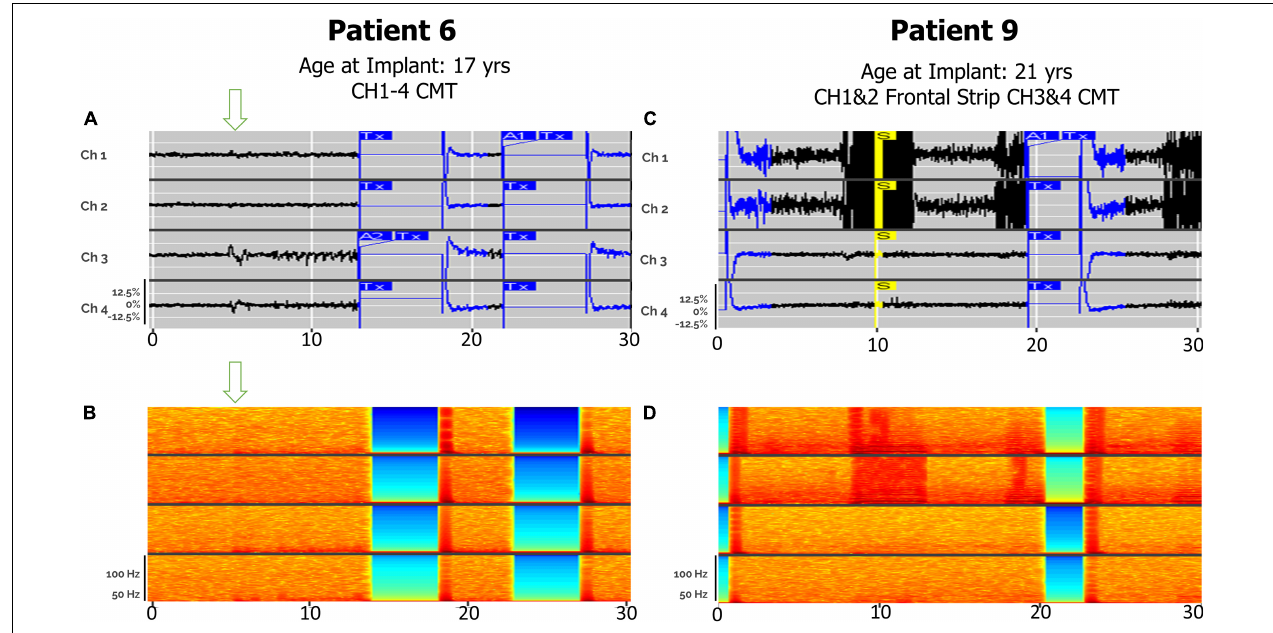
FIGURE 4 | Electroclinical seizures detected in CMT, with and without cortical strip leads, recorded by the RNS system over a 30-s window. Arrows denote seizure onsets. (A) An example of an electroclinical seizure consisting of myoclonic jerks in Patient 6, captured with bilateral CMT leads over a 30-s window. Ch 1. R-CMT1–R-CMT2; Ch 2. R-CMT3–R-CMT4; Ch 3. L-CMT1–L-CMT2; Ch 4. L-CMT3–L-CMT4. (B) Spectrogram of identical epoch. (C) An example of an electroclinical seizure in Patient 9 that was ongoing at the time of capture, detected with left frontal cortical strip (Fnt) + right CMT depth leads over a 30-s window with saturation in the cortex and subsequent spread to CMT thalamic leads. Ch 1. L-Fnt1–L-Fnt2; Ch 2. L-Fnt3–L-Fnt4; Ch 3. R-CMT1–R-CMT2; Ch 4. R-CMT3–R-CMT4. (D) Spectrogram of identical epoch. S, Saturation; A2, Pattern A, 2nd